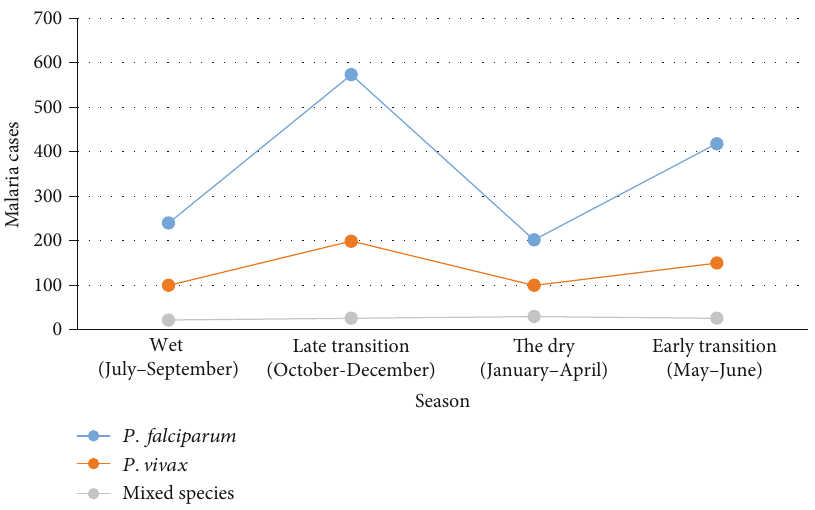
Figure 4: The distribution of Plasmodium species in di ff erent seasons at Dembecha Health Center from 2011/12 to